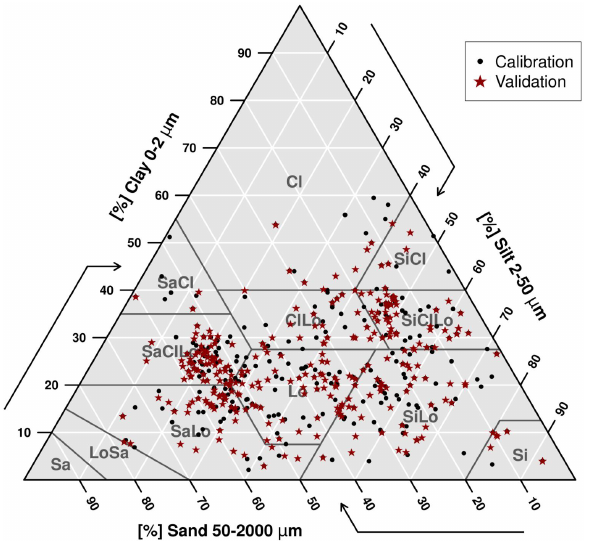
Figure 3. Distribution of soil textures for calibration (450 points) and validation (450 points) data. Abbrevations are as follows: clay (Cl), sand (Sa), silt (Si), loam (Lo), sandy clay (SaCl), silty clay (SiCl), sandy clay loam (SaClLo), clay loam (ClLo), silty clay loam (SiClLo), sandy loam (SaLo), silty loam (SiLo) and loamy sand